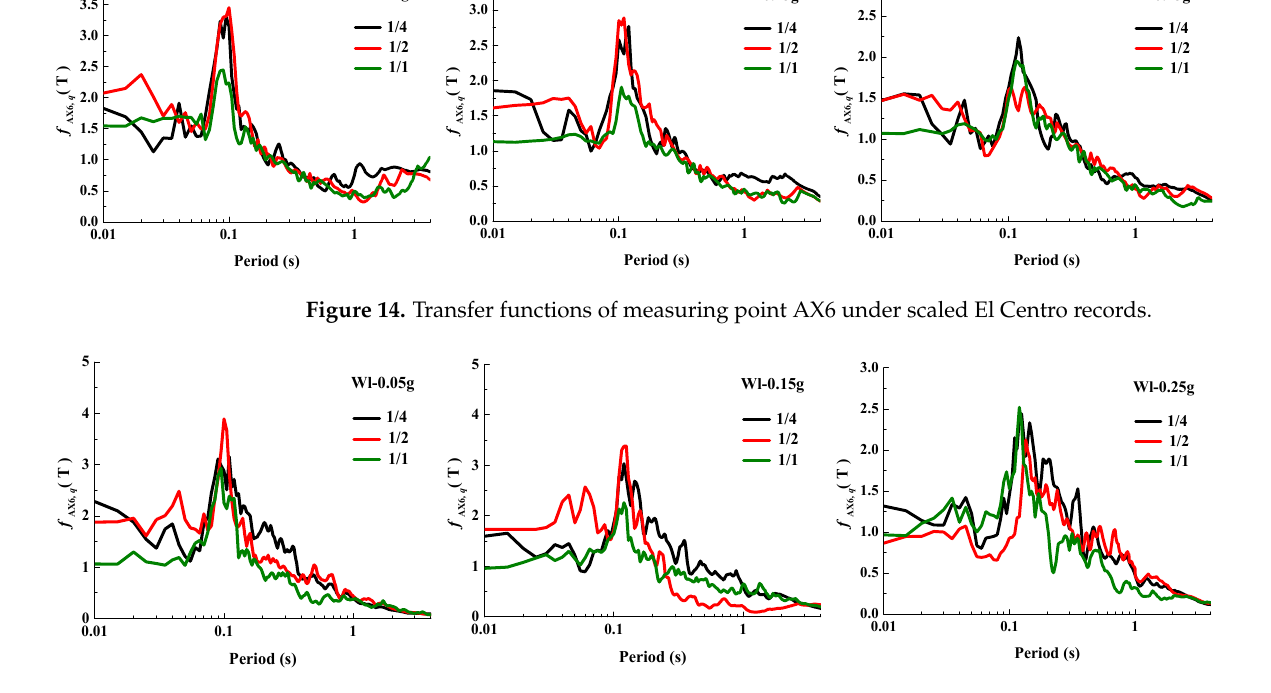
Figure 15. Transfer functions of measuring point AX6 under scaled Wolong records.